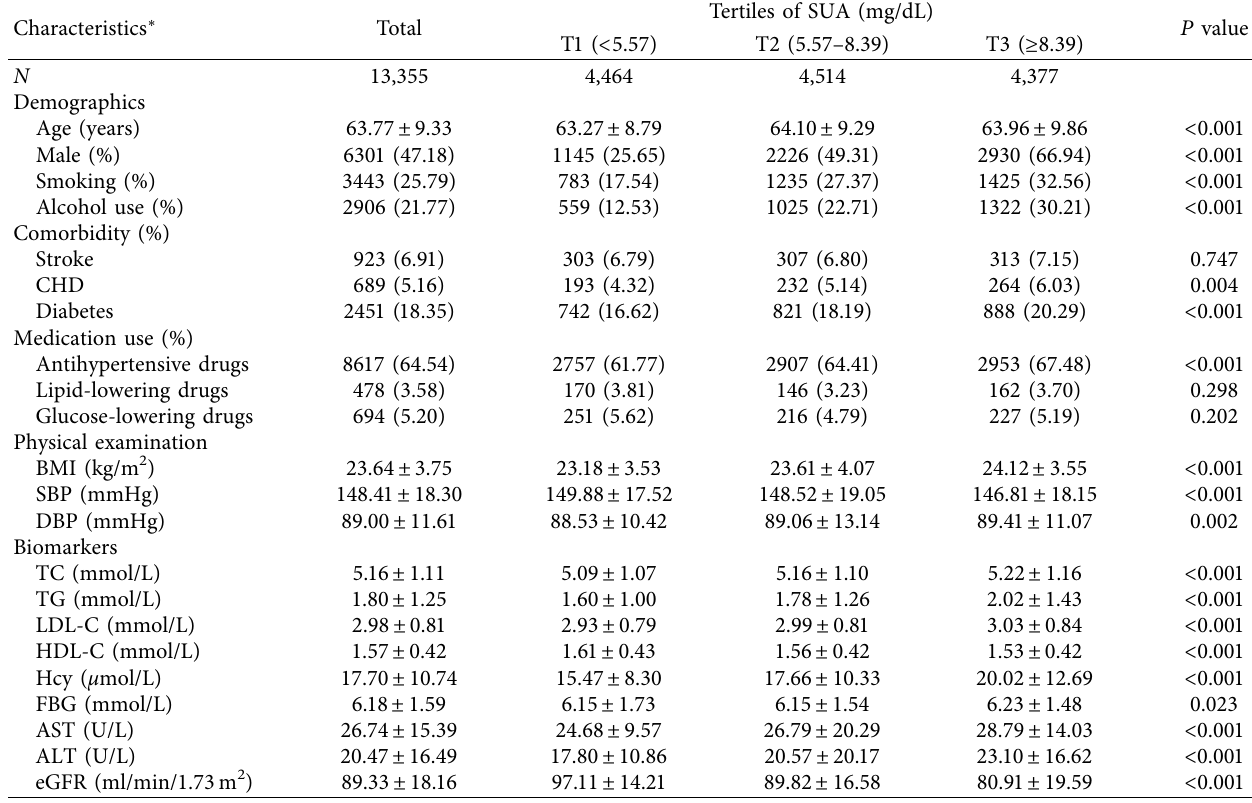
Table 1: Characteristics of study population.